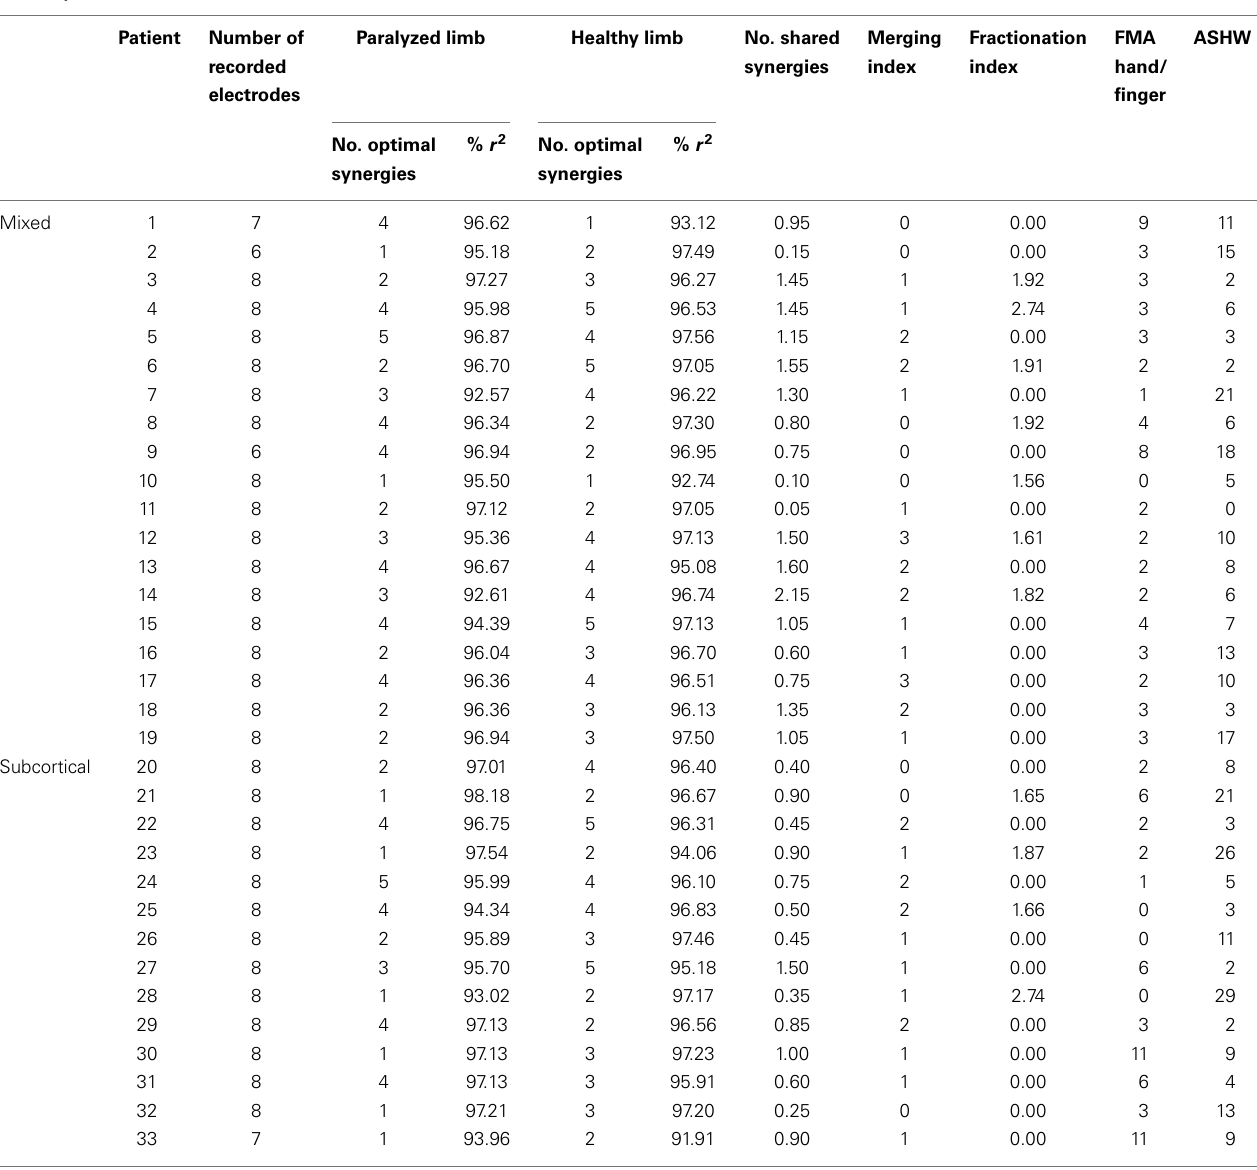
Table 1 | Patients lesion, synergy information, and functional state of paralyzed upper limb . Patient Number of